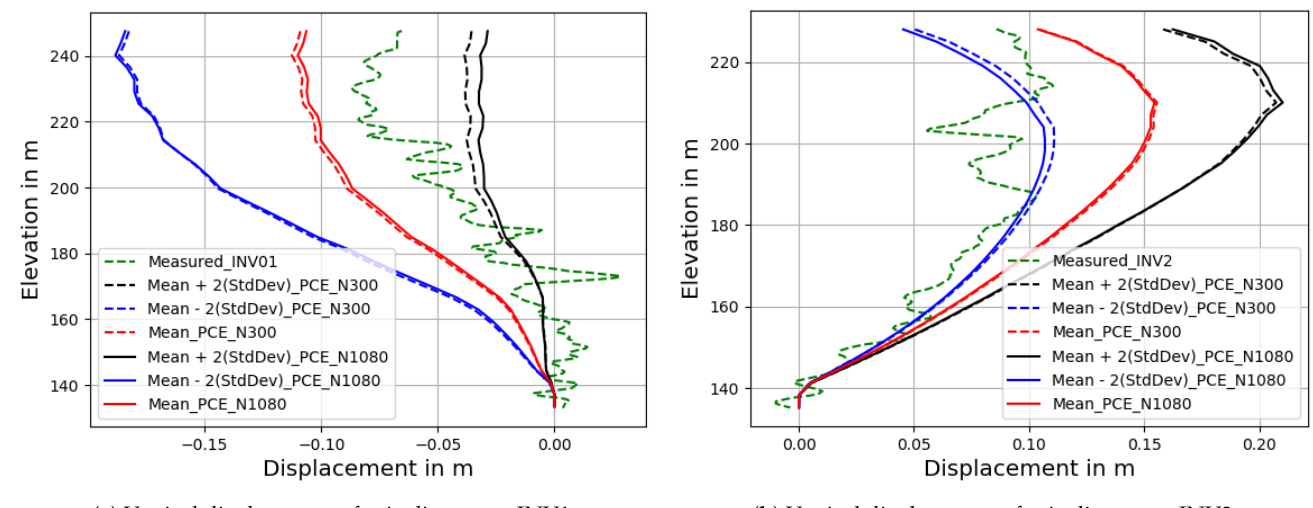
Figure 9. Confidence intervals using polynomial chaos expansion-based surrogate